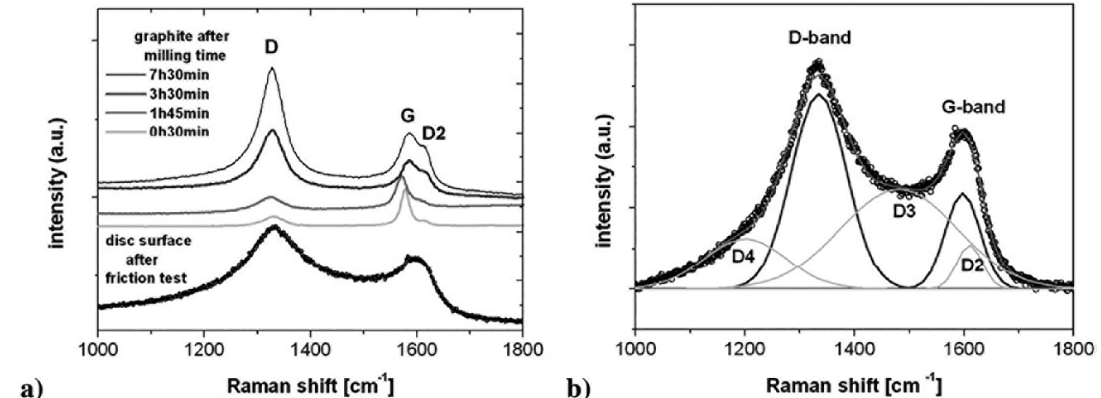
Figure 3. a) Micro-Raman spectra from graphite milled in shaker mill for different times (indicated) and spectrum from the disc surface after the AK-master friction test; b) Fitting of the Raman spectrum of carbonaceous material from the disc surface with five Gaussian bands.